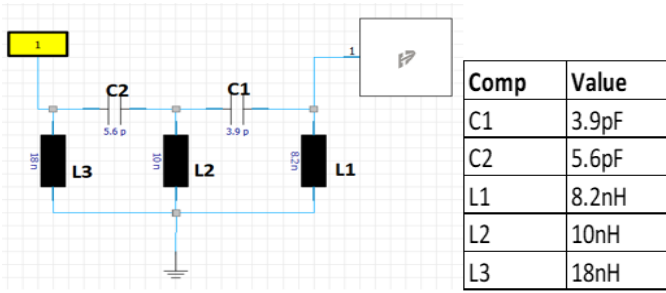
Figure 12. Antenna matching circuit and component values.